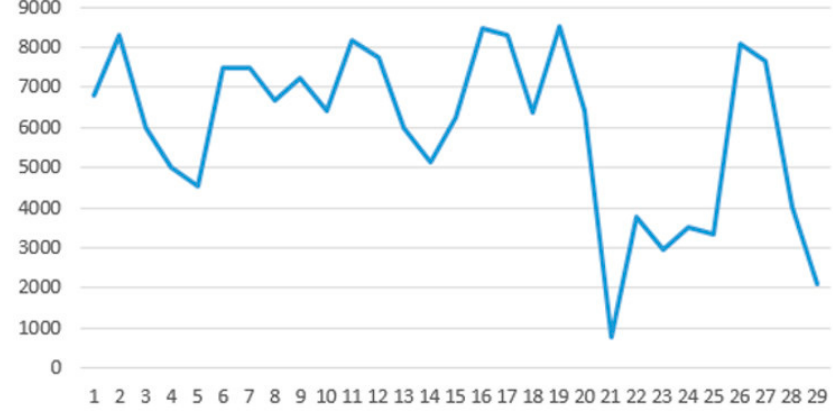
Figure 12. Yeongam Photovoltaic Power Plant Power generation in August 2018. In the picture below, Series 1 refers to the frequency at which a particular word ap- pears, whereas Series 2 indicates the power consumption of each corresponding year. The high pressure positioned near our country and the strong solar radiation in early August,